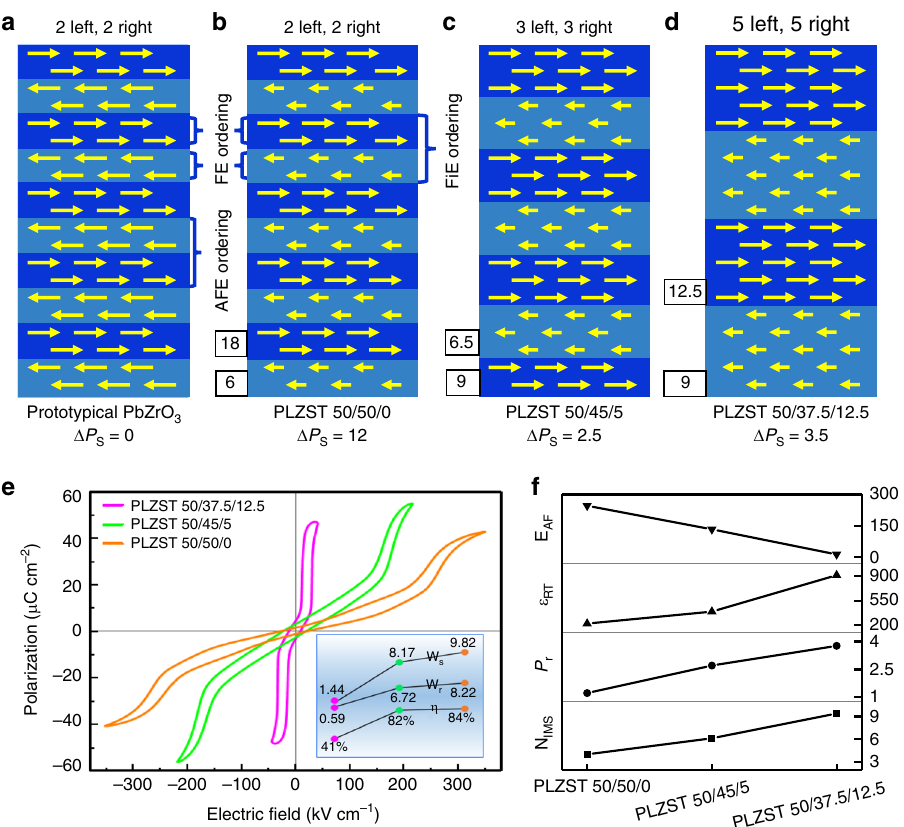
Fig. 5 Interplay of AFE, FiE, and FE ordering and structure – property correlation. a – d Ideal models of dipoles ordering con fi gurations in PbZrO 3 and PLZST system. Arrows with left and right orientations represent the dipoles. The polarization value of FE segments in PLZST system is based on the quantitative data in Fig. 4. The Δ P s refers to the net polarization of two adjacent FE segments (in unit of μ C cm − 2 ). e, f Hysteresis loops, modulation period ( N IMS ), remanent polarization (P r , μ C cm − 2 ), dielectric constant ( ε RT ) and forward switching fi eld (E AF , kV cm − 1 ) of PLZST system. The inset in ( e ) shows the energy storage density (W s , J cm − 3 ), recoverable energy density (W r , J cm − 3 ) and energy ef fi ciency ( η )